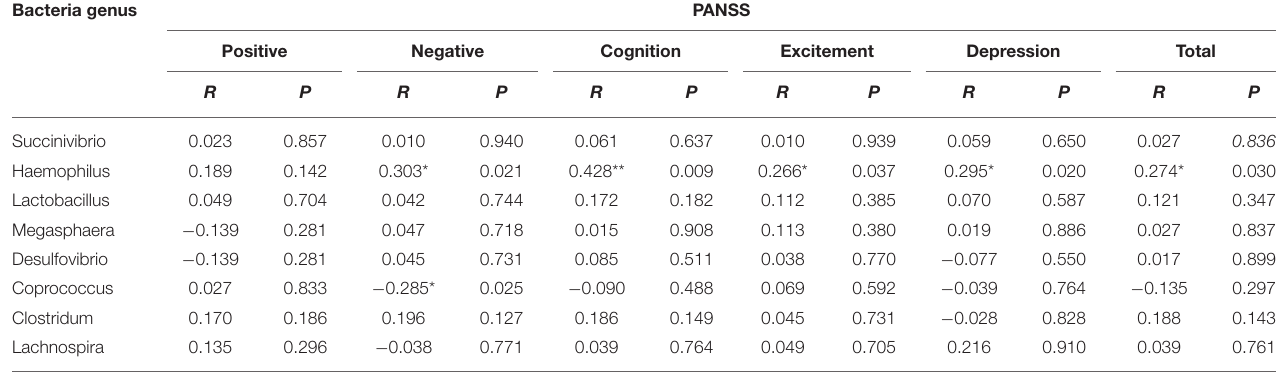
TABLE 2 | Correlation analysis between bacterial genus and PANSS. Bacteria